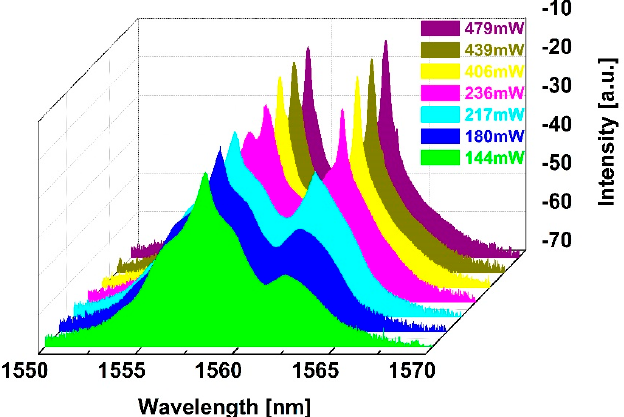
Figure 7. Dual-wavelength evolutionary process.